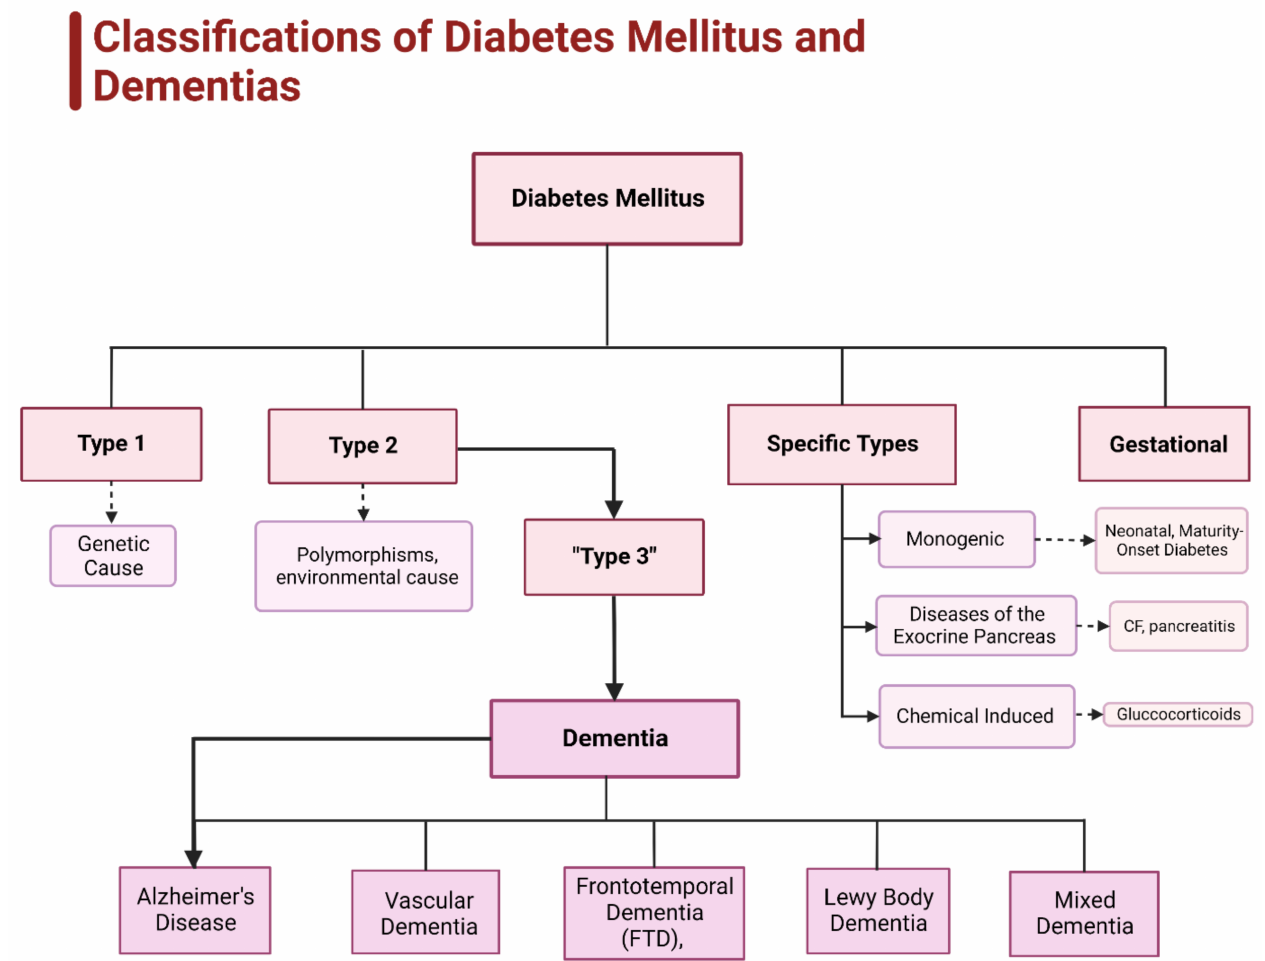
Figure 3. Classifications of diabetes mellitus and dementias. Figure illustrates the four types of diabetes mellitus and the relationship between type 2 diabetes mellitus (T2DM) and dementia, specifically Alzheimer’s disease (AD). T2DM has a close link to AD, leading to an umbrella type of diabetes known as “type 3 diabetes mellitus”